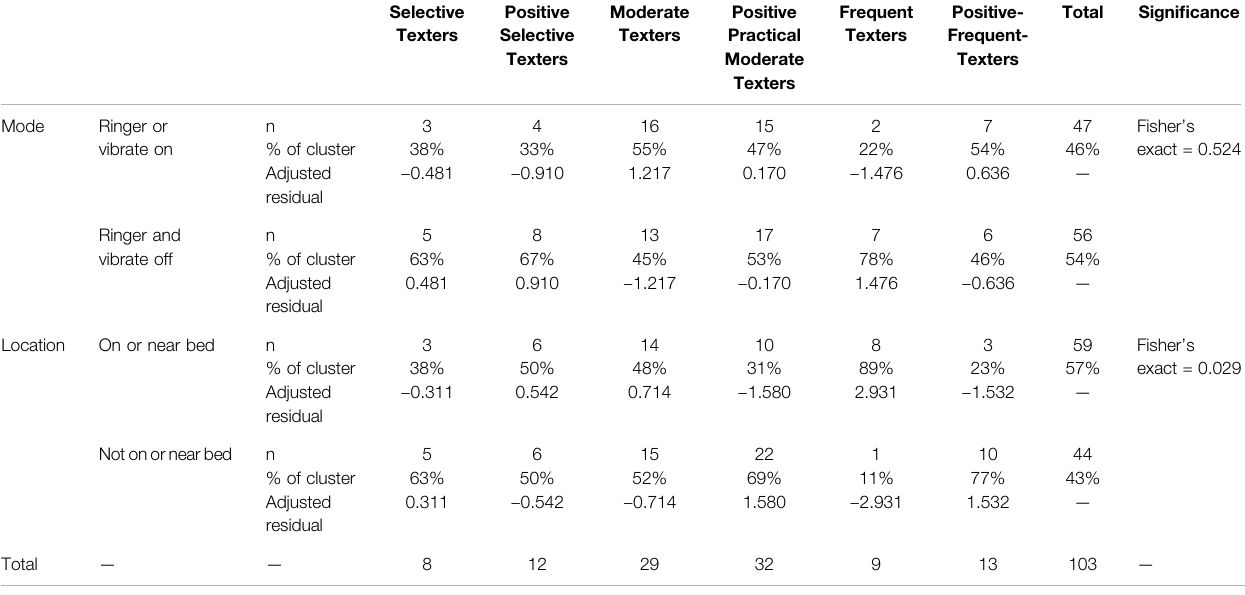
TABLE 2 | Cell phone habits during sleep.